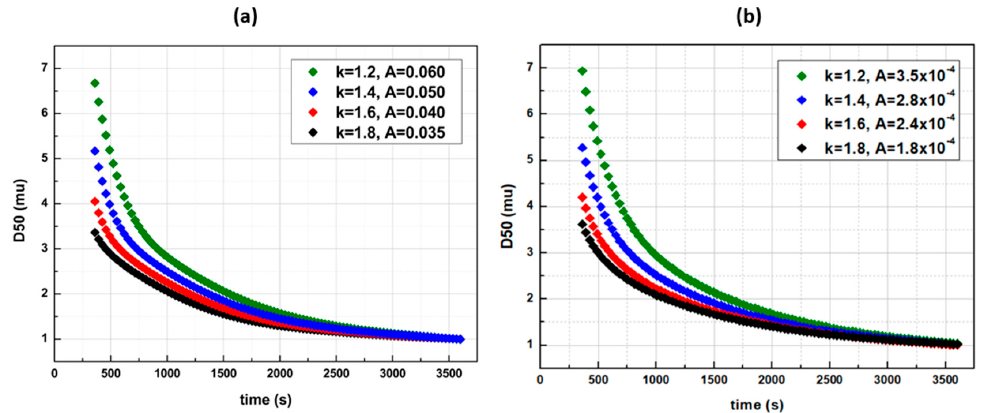
Figure 9. Kapur’s breakage function for a D50 = 1 µ m final size via ( a ) various time profile paths with e = 6 and ( b ) various profile paths with e = 1.25 (de Vegt approximation).